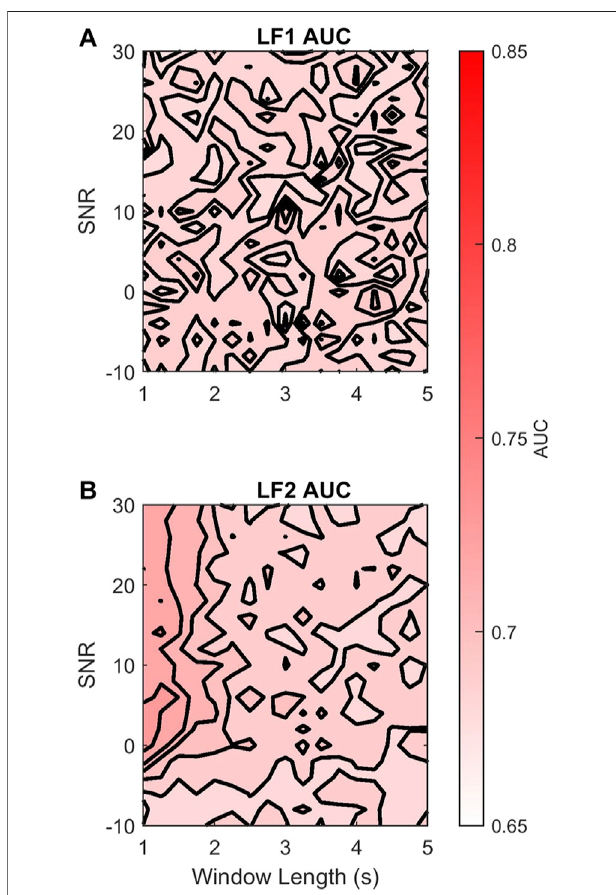
FIGURE 8 | Contour plots of the median AUC DUS of the (A) LF1 and (B) LF2 sub-bands for varying AC window length (horizontal axis) and SNR (vertical axis). The AUC DUS are coded in colors white (0.65), and red (0.85) according to their magnitude. For visualization, 5 isolines are used in each